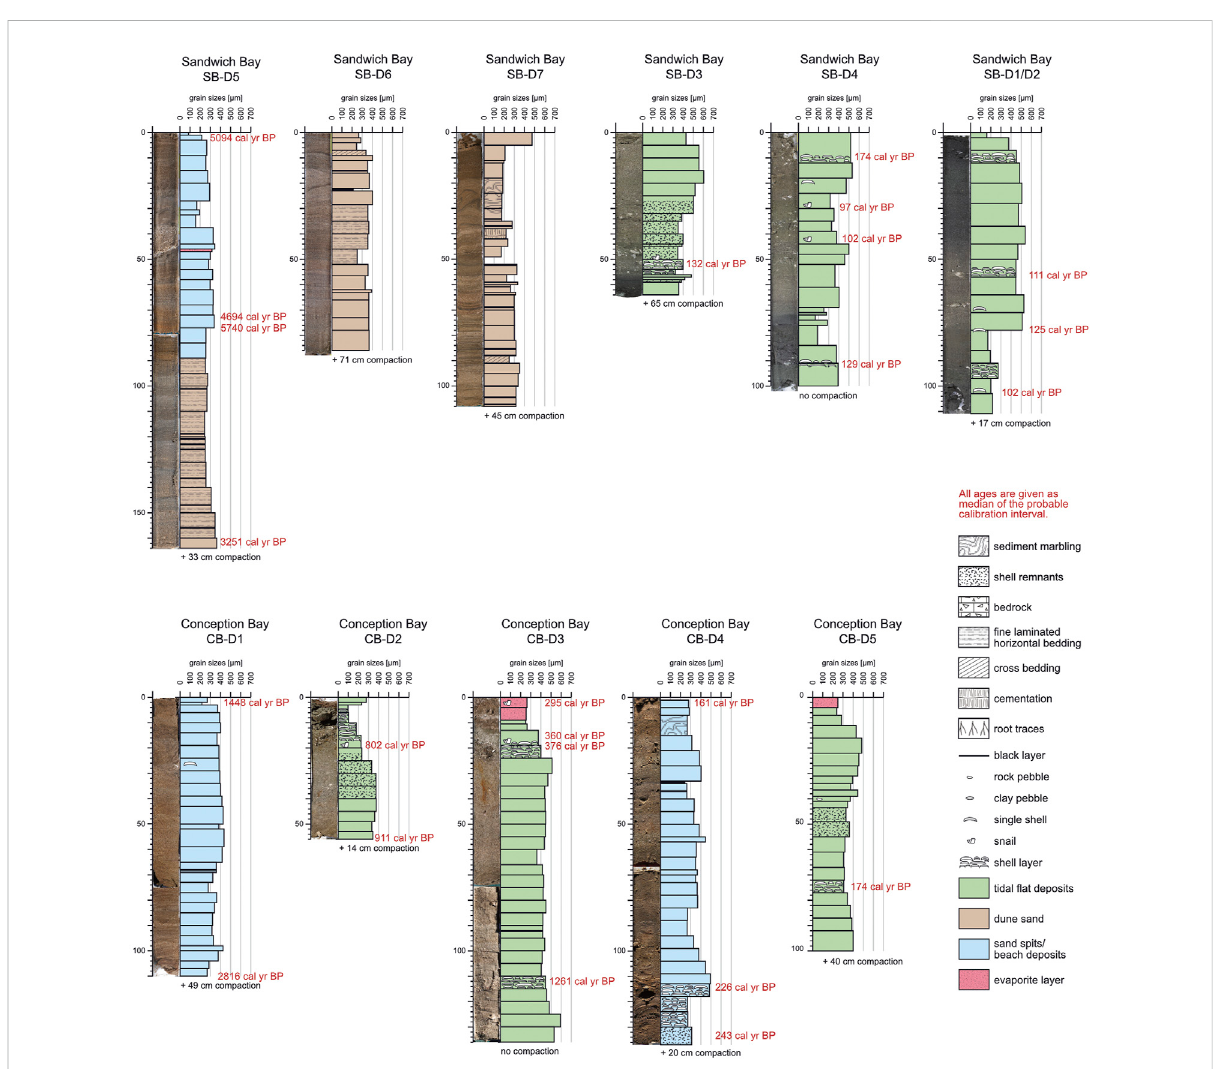
FIGURE 4 Photos and logs of the sediment cores investigated in the southern (paleo-)lagoons (Sandwich Bay, Conception Bay) with an illustration of the mean grain sizes (per sampling interval), calibrated 14 C ages (given as median probability, for 2 σ intervals see Supplementary Table S4), faunal remnants, and primary as well as secondary sedimentary